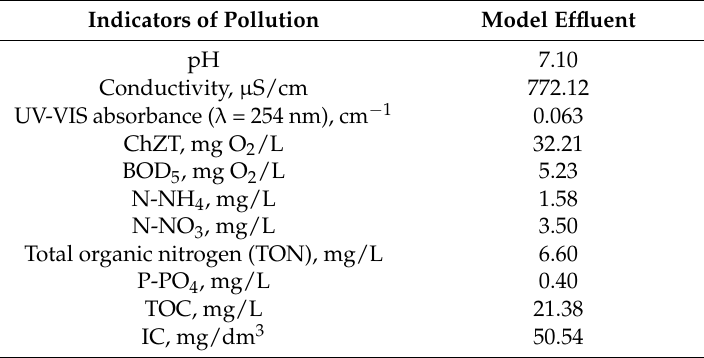
Table 2. Characteristics of the water matrix.